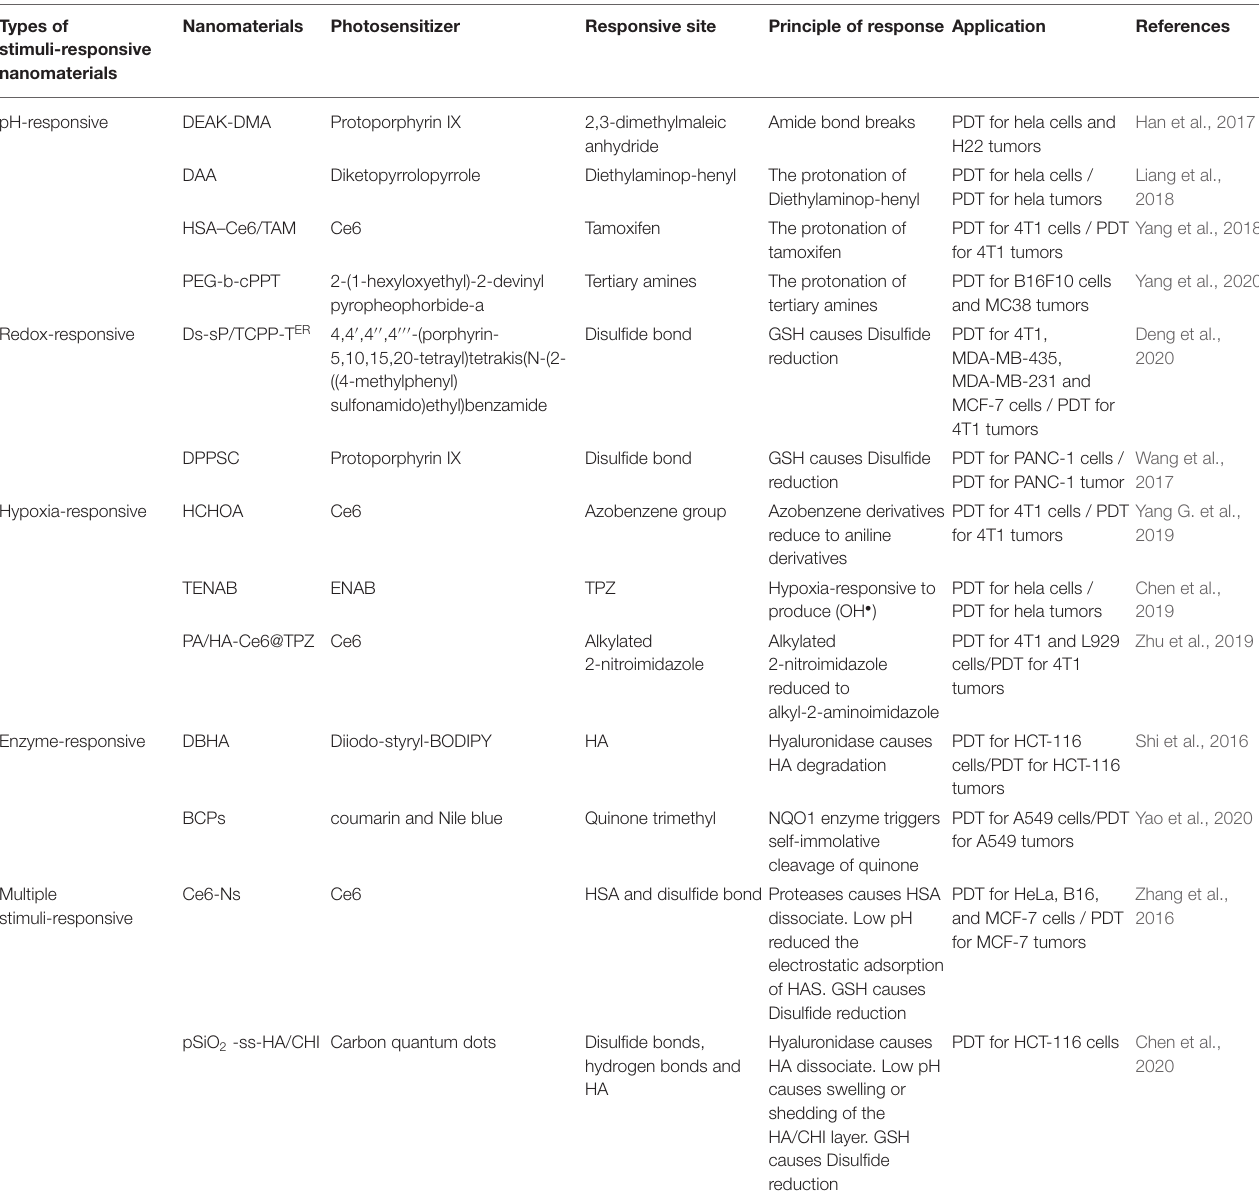
TABLE 1 | Summary of tumor microenvironment-responsive nanomaterials for